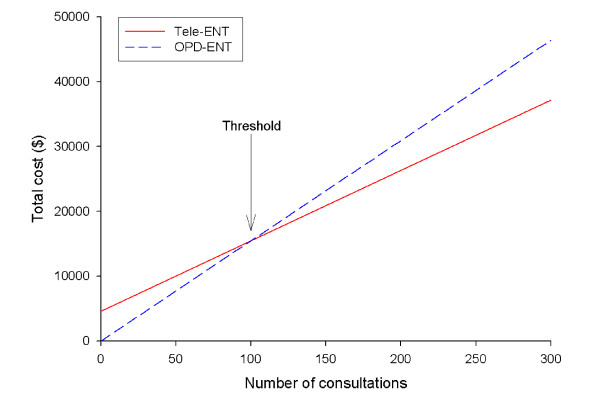
Threshold analysis.